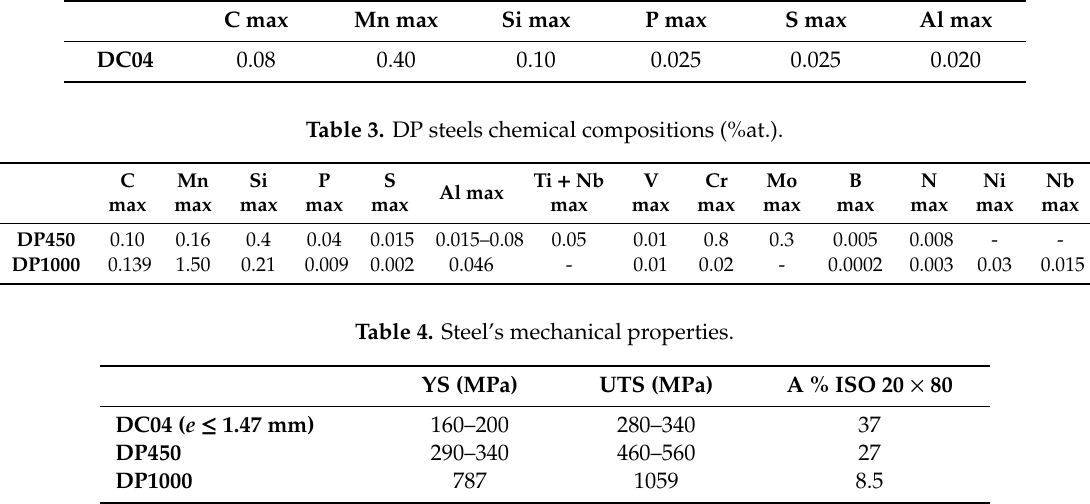
Table 2. DC04 steel chemical compositions (%at.).